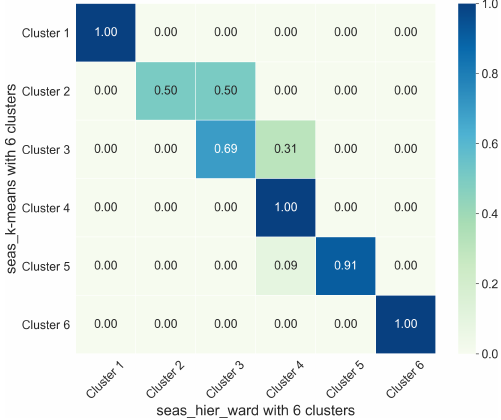
Figure 8. Relationship between the clusters determined by the K-means and hierarchical model with the ward criterion for K =